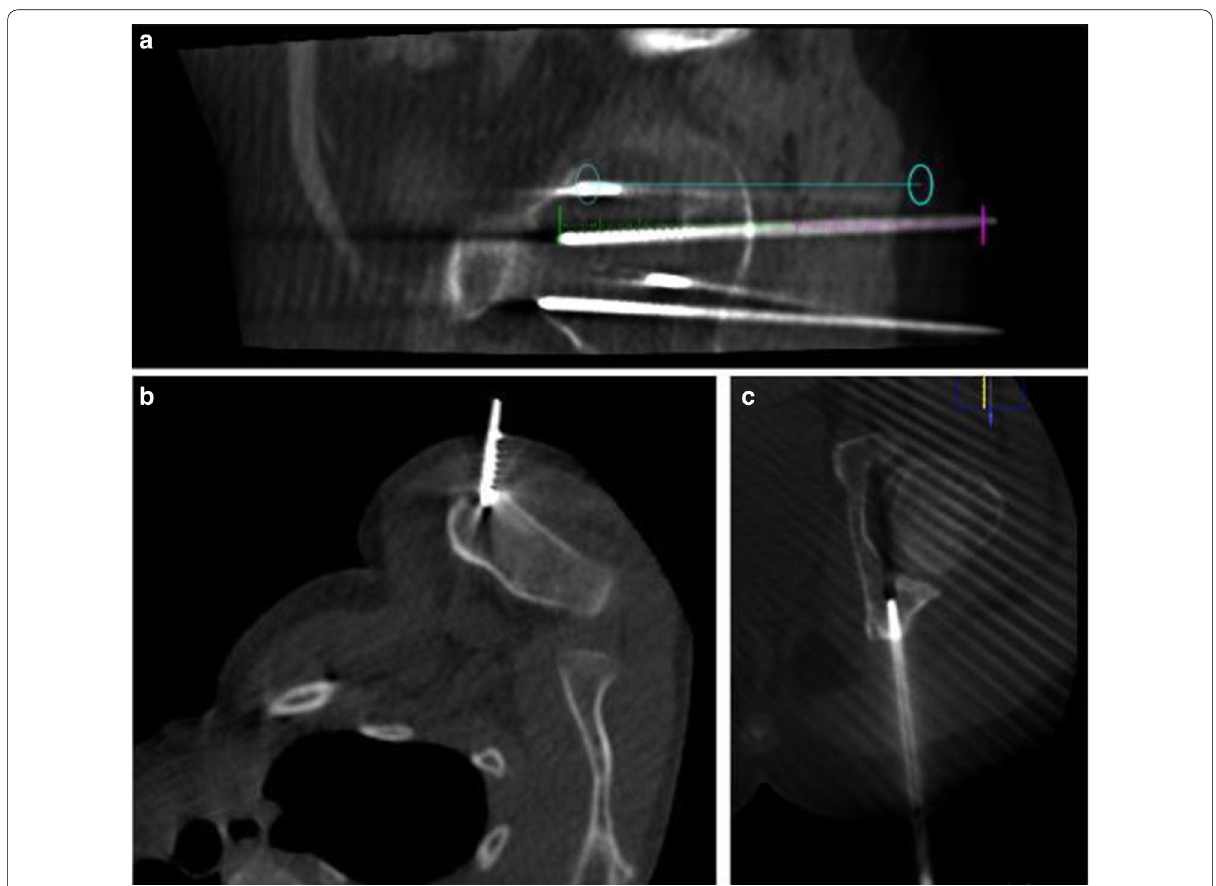
Fig. 1 Procedure planification. a Live fluoroscopy is projected over a previously acquired three‑dimensional data set using cone‑beam CT guidance and XperGuide tools. The blue line represents the planned needle course derived by cone‑beam CT, which was planned on a separate three‑dimensional workstation. b , c Cryoprobes trajectories placed inside the